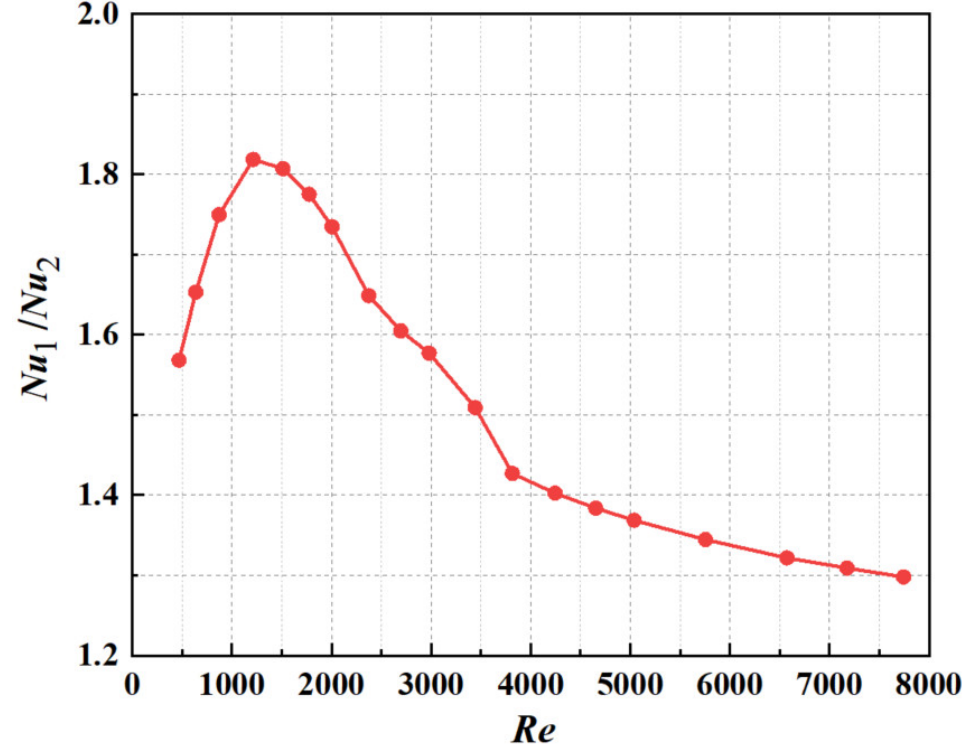
Figure 29. Nusselt number ratio of the protrusions to the primary wall as a function of Reynolds Figure number.